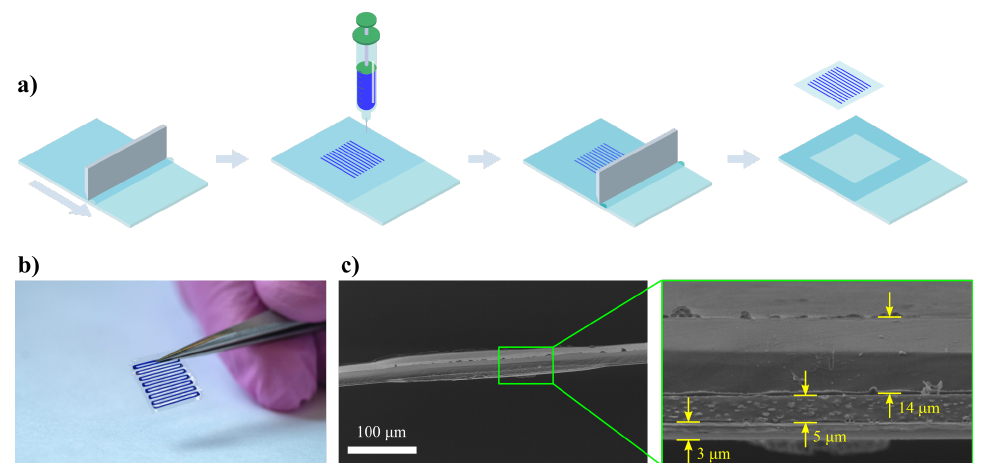
Figure 1. ( a ) Manufacturing routine for the production of drug-eluting films, including base film application, automatic cargo dispensing, and sealing. ( b ) Typical appearance of a sample used in this research. ( c ) SEM image of the internal structure of the